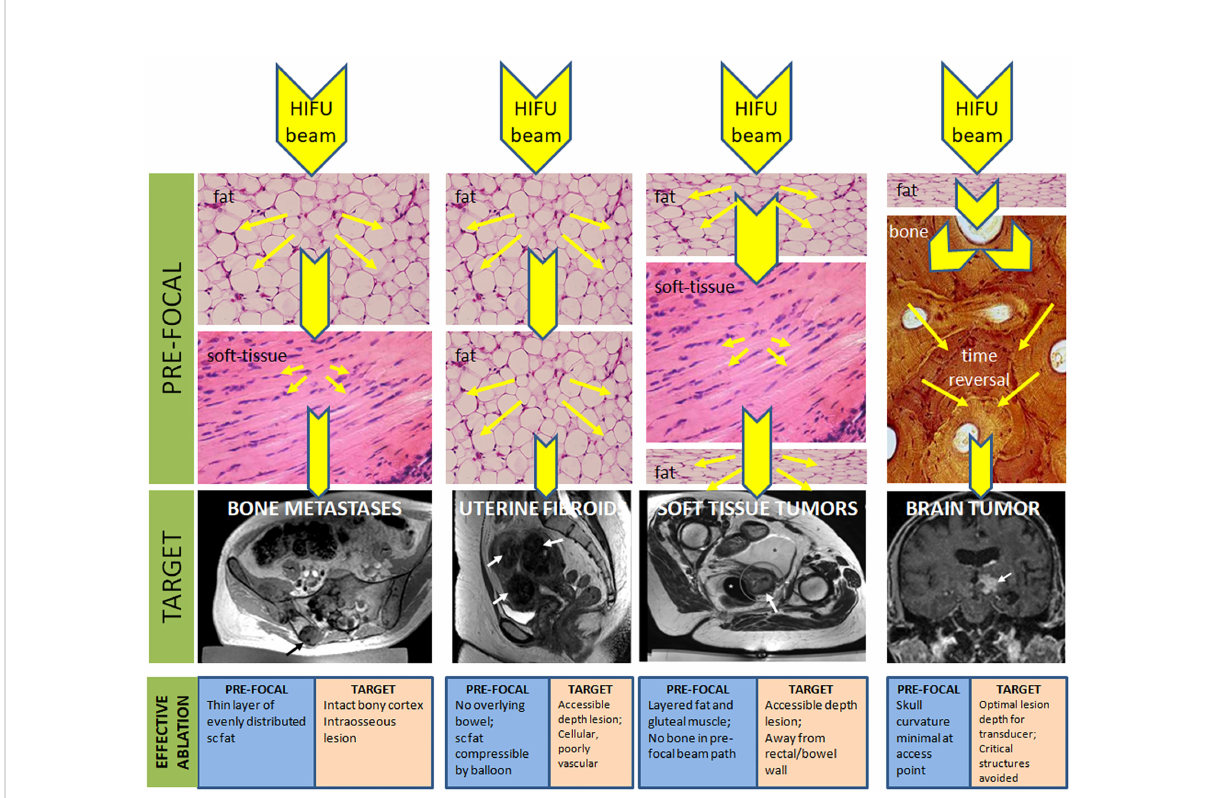
FIGURE 1 Pre-focal and target tissue considerations for achieving effective thermal ablation with HIFU. Reduction in the beam energy as it traverses tissues with different characteristics in the pre-focal region are given by reduction in size of the yellow arrowheads (not to scale) because of dispersion of the beam energy (yellow arrows). With bone in the pre-focal path, a time reversal technique is required to re-focus the beam. Favorable considerations of the pre-focal and target tissues to achieve effective ablation are